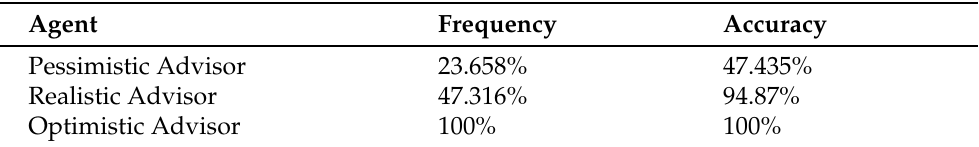
Table 1. The three simulated users designed for the experiments. These users are not intended to be compared against each other, rather with a persistent